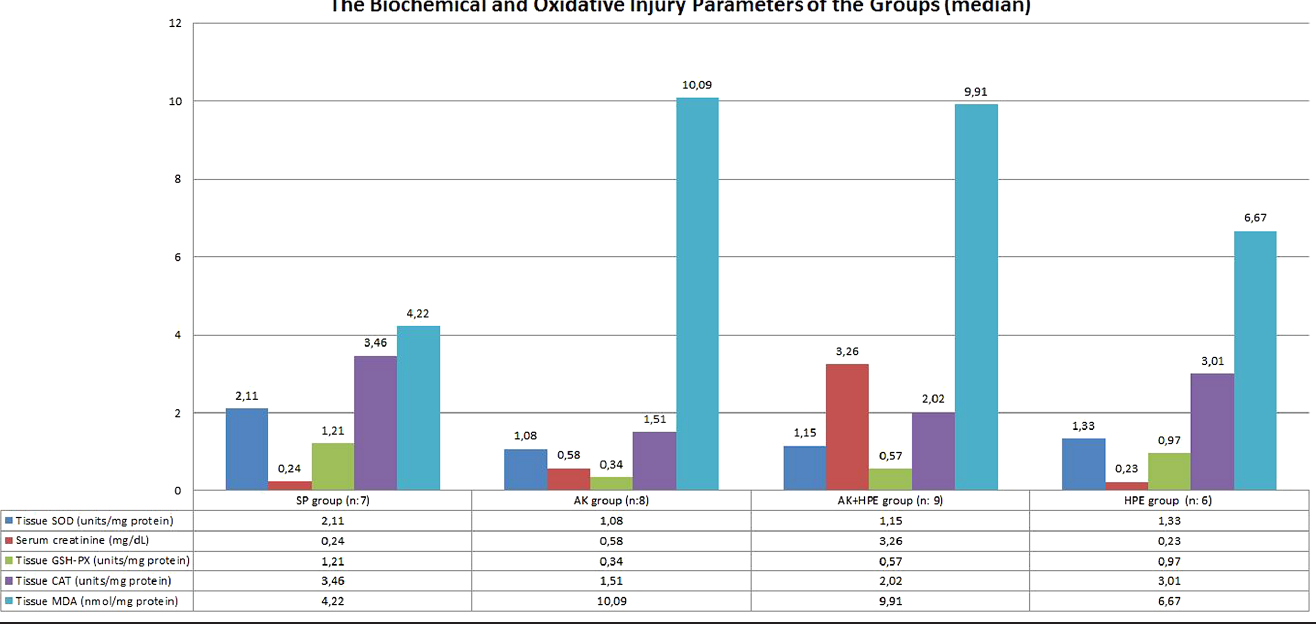
HPE groups with regard to kidney CAT levels. The CAT levels were lower in the AK group than the others, the AK+HPE group had CAT levels higher than the AK group and lower than SP and HPE groups. The GPX levels of AK and AK+HPE groups were sig- nificantly lower than SP and HPE groups. The AK group had sig- nificantly lower SOD levels than SP and HPE groups and the SP